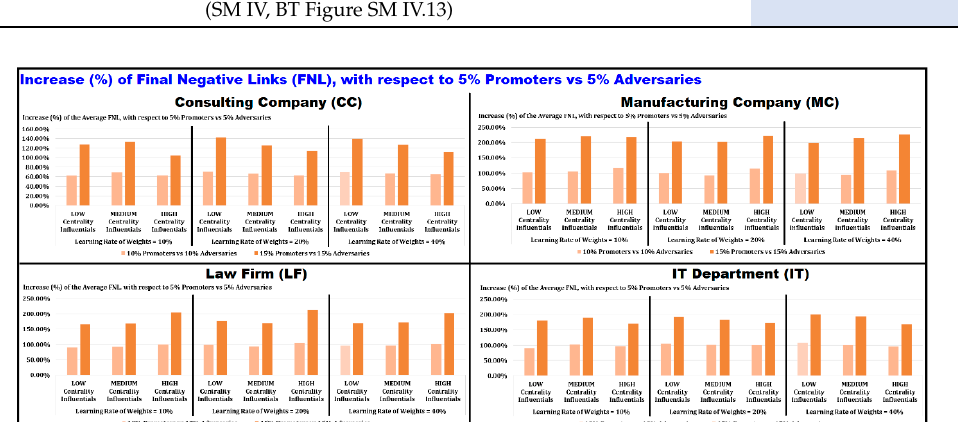
Figure 6. Relative Increase (%) of Final Negative Links (blue horizontal lines in Figure 4) for the selected values of centrality and learning rate (Table 3). The increase of Final Negative Links when promoters and adversaries increase from 5% to 10% is indicated in the left column. The right column (darker) shows the increase when promoters and adversaries increase from 5% to 15%.